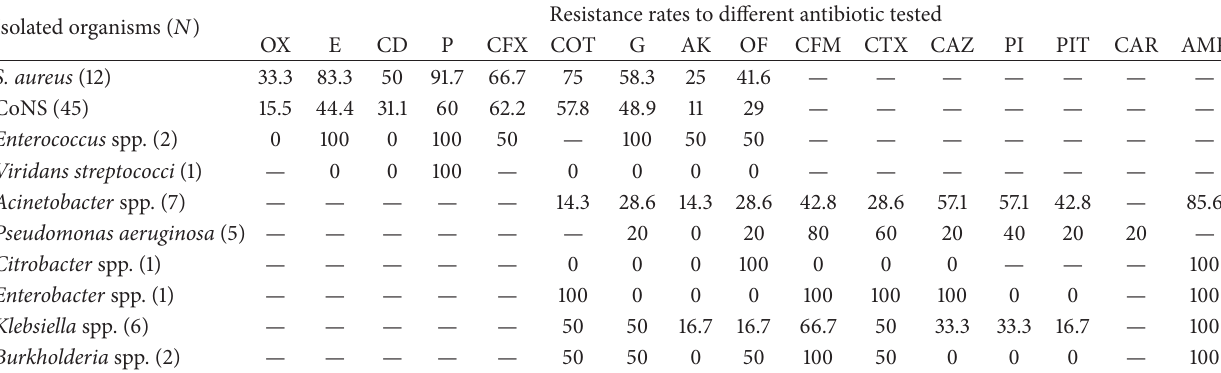
Table 3: Resistance rates of isolates recovered from early-onset cases.